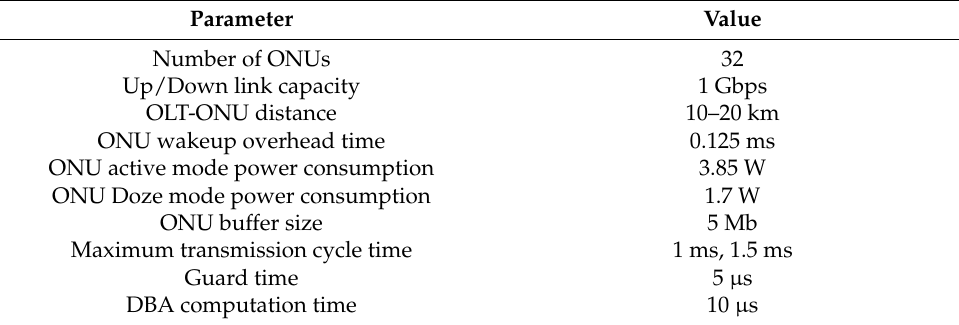
Table 1. Simulation